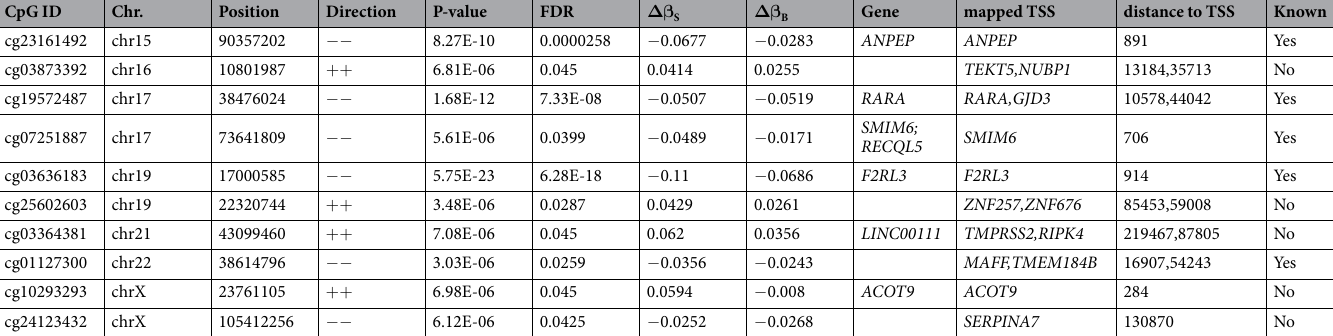
Table 1. Summary of the 58 DMPs detected in blood of MS patients between W5Y vs . NS. The CpG site is marked as known if present in reference 12 ; Δβ : average methylation difference between W5Y and NS; TSS: transcription start